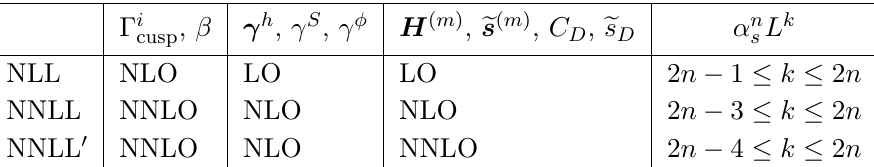
Table 1 . Our naming scheme for the logarithmic accuracies. We list the perturbative orders at which the cusp anomalous dimension, the QCD (cid:12) -function, all other anomalous dimensions and matching functions need to be evaluated in order to obtain resummation at a given logarith- mic